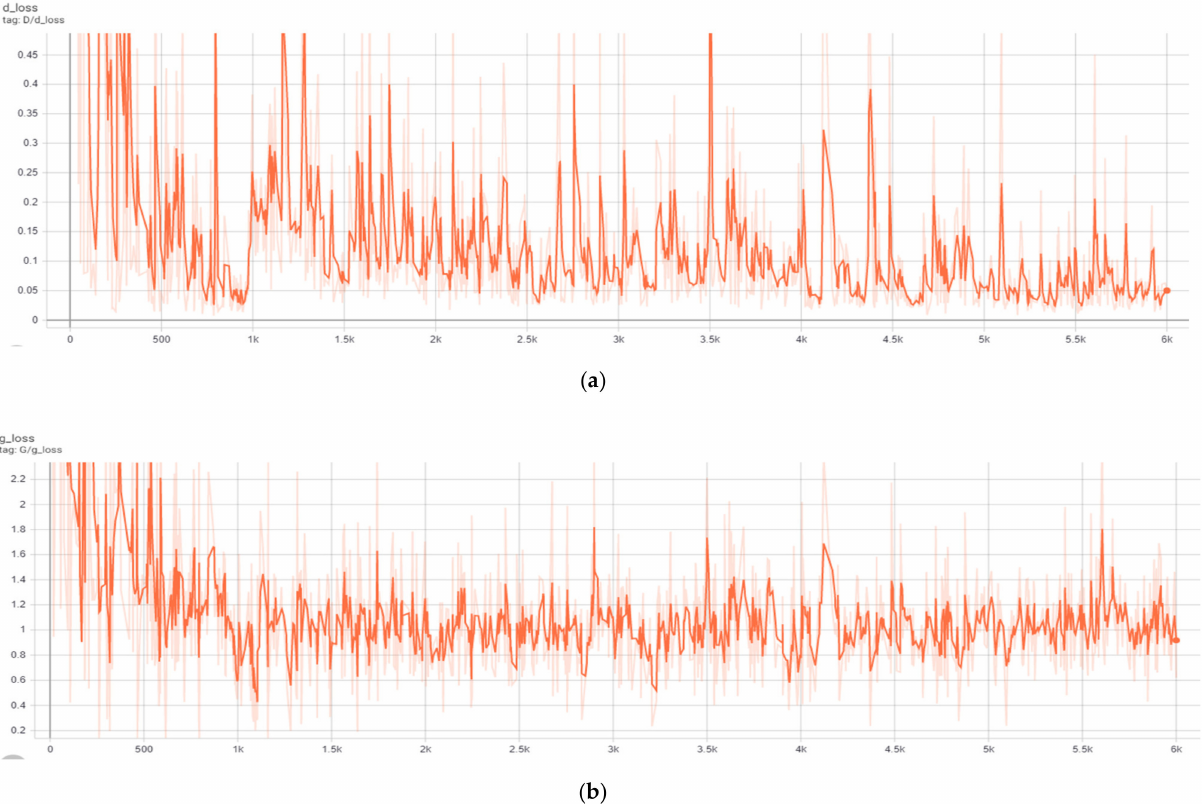
Figure 4. LSGAN training process ( a ) d_loss, and ( b )